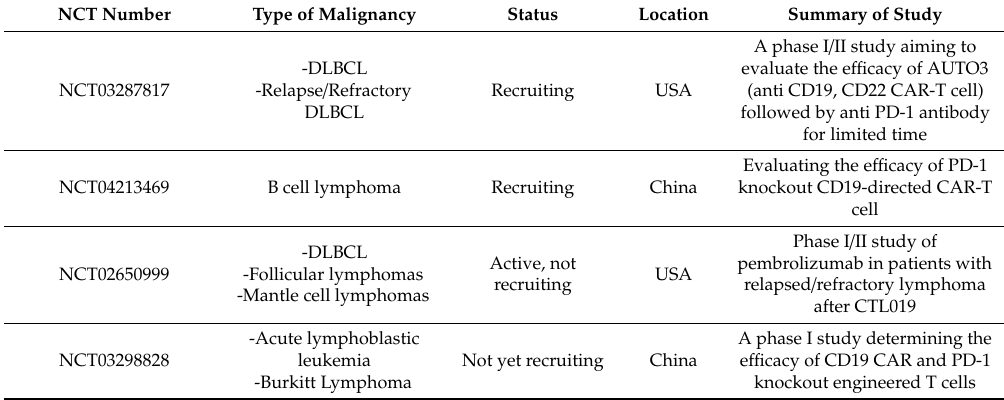
Table 4. Ongoing clinical trials of PD-1 and CAR-T cells combination in hematological malignancies